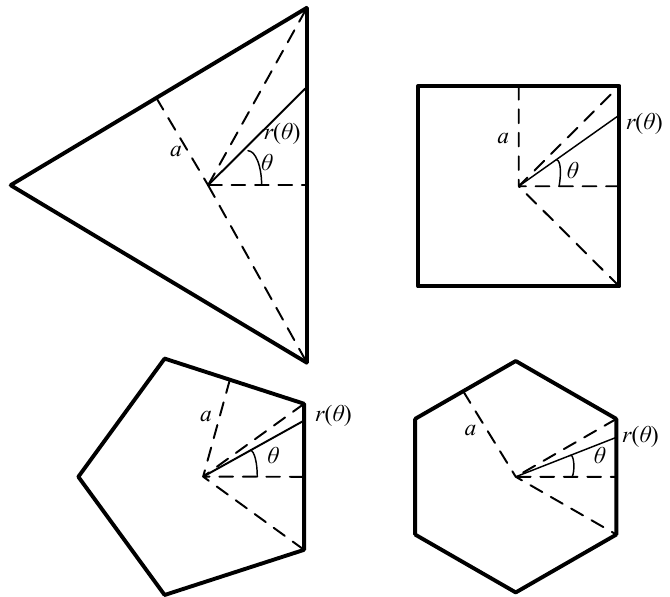
Figure 2. An illustration of regular polygon shape entropy calculations.